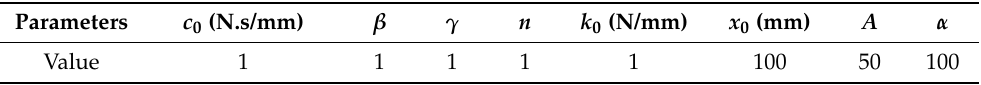
Table 1. Initial values of Bouc-Wen model parameters.